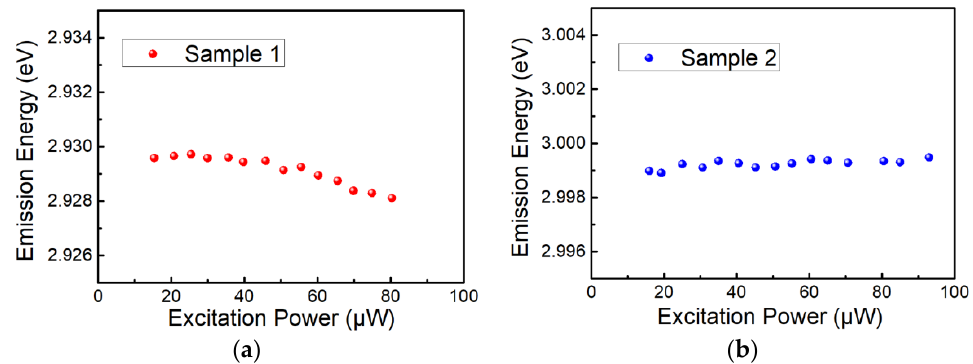
Figure 6. Emission energy as a function of excitation power for ( a ) Sample 1 and ( b ) Sample 2, measured at RT.